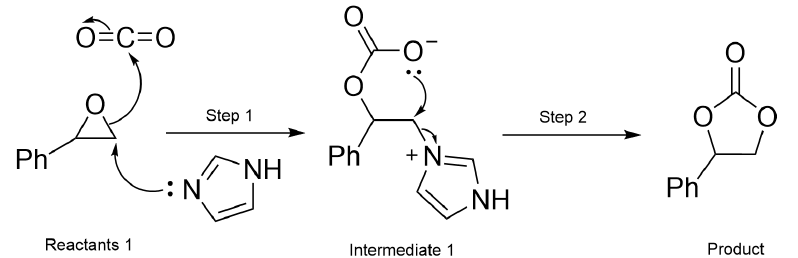
Scheme 2. Proposed reaction mechanism for the Lewis base catalysed cycloaddition of CO 2 into